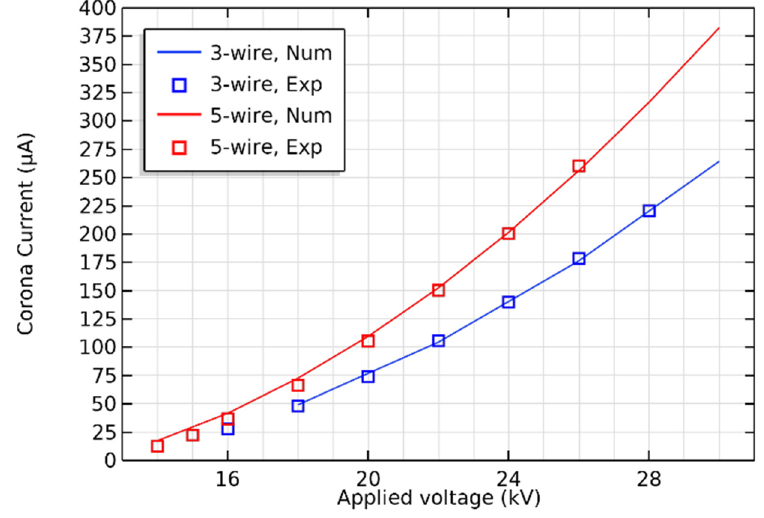
Figure 5. Corona current-voltage characteristics of various ESPs with 3 and 5 discharge electrodes per channel.